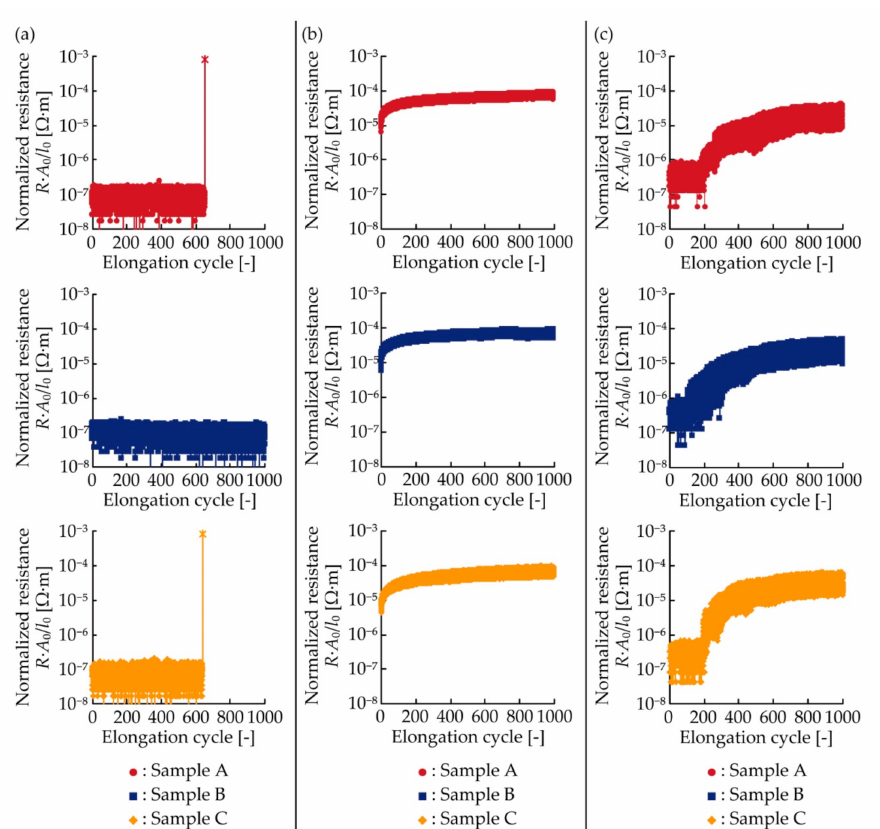
Figure 8. Normalized resistance plotted against elongation cycle for ( a ) meandering copper; ( b ) silver ink; and ( c ) double-layered patterns, under cyclic tensile